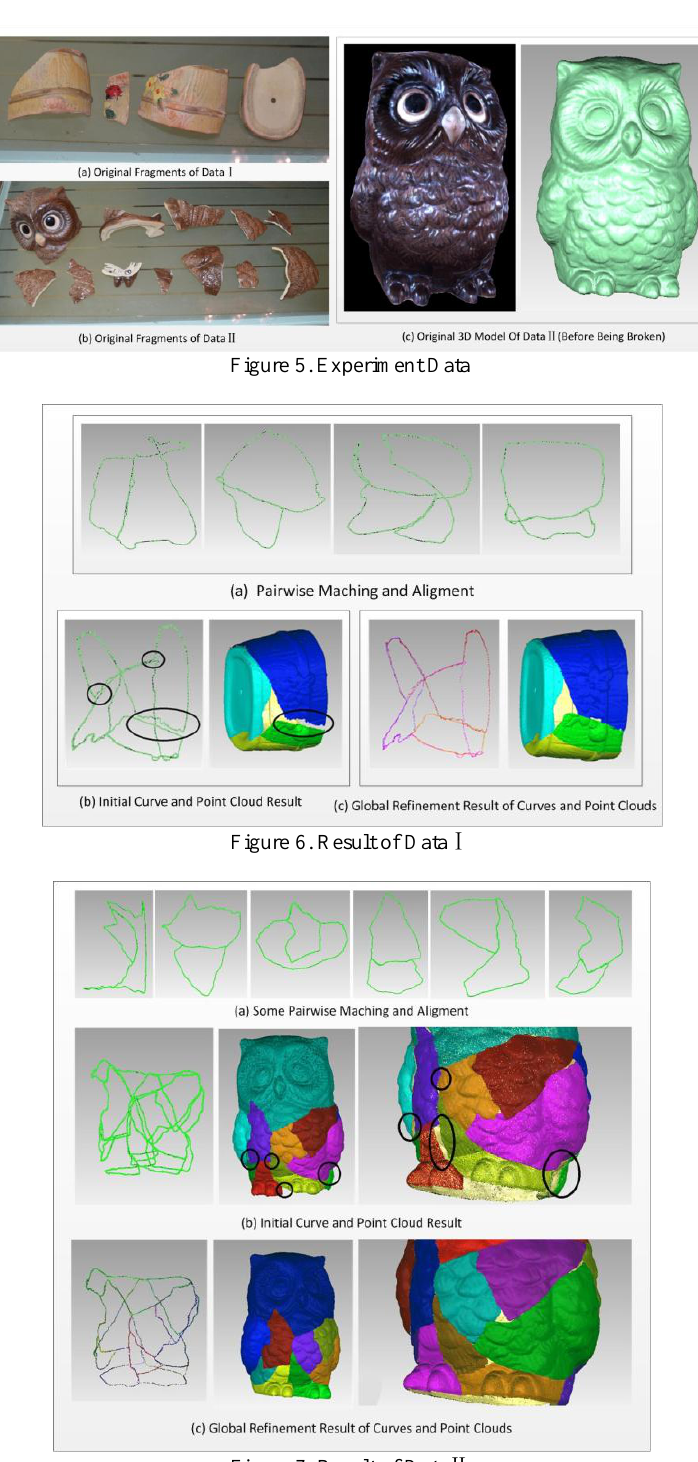
Figure 7. Result of Data